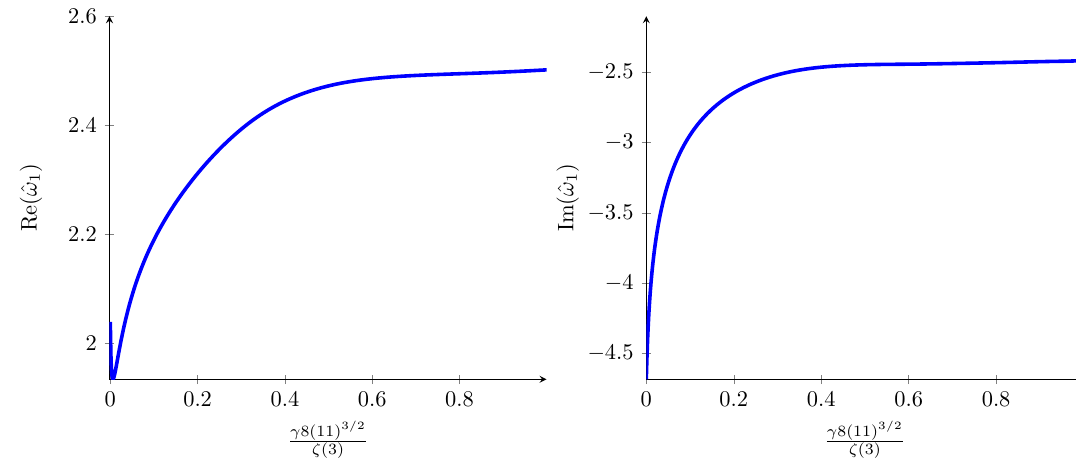
Figure 7 . The coupling corrected and resummed imaginary and real part of the lowest QNM with b = 5 and q = 0 averaged over di(cid:11)erent grid sizes and interval sizes. The maximal deviation from 4 those suggest a negligible error for large (cid:21) , an error of 1% for the imaginary part and 10% for (cid:25) (cid:25) the real part for (cid:21) 11. Interestingly the average values as well as the curves for large M and large ! 3 = 2 interval sizes [ l; k ] converge for (cid:13) 8(11) 1, or (cid:21) 11 to 2 b (1 i ). The constant shape of the (cid:16) (3) ! ! (cid:0) curve at small (cid:21) suggests that this is also the limit towards which the mode converges for (cid:21) 10. (cid:28)